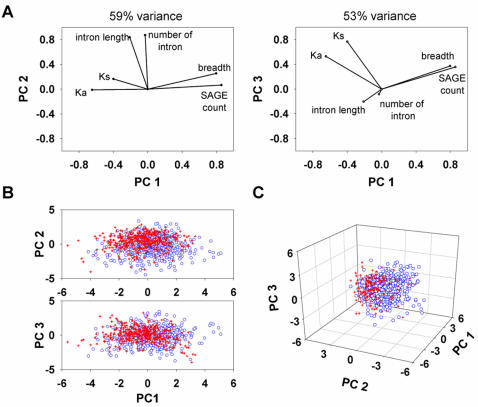
Principal component analysis (PCA). A, PCA analysis using six variables at either 53% (left) or 59% (right) variance.B, Two-dimensional dot plots confirming the existence of distinct PCI+ gene subsets (red cross, low GC; blue circle, high GC) based on intron size/number, transcription, and evolutionary rate. C, Three-dimensional dot plot of the GC-rich (blue) and GC-poor (red) PCI+ gene clusters.